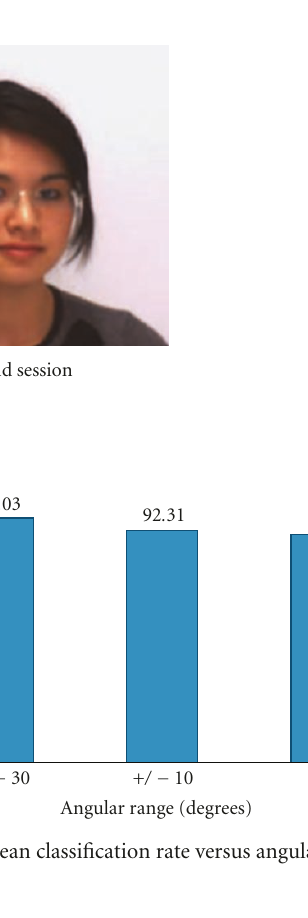
Figure 7: Database capture conditions: (a) Overhead light with neutral expression, (b) Overhead and frontal light with neutral expression, (c) Overhead and frontal light with varying facial expressions.